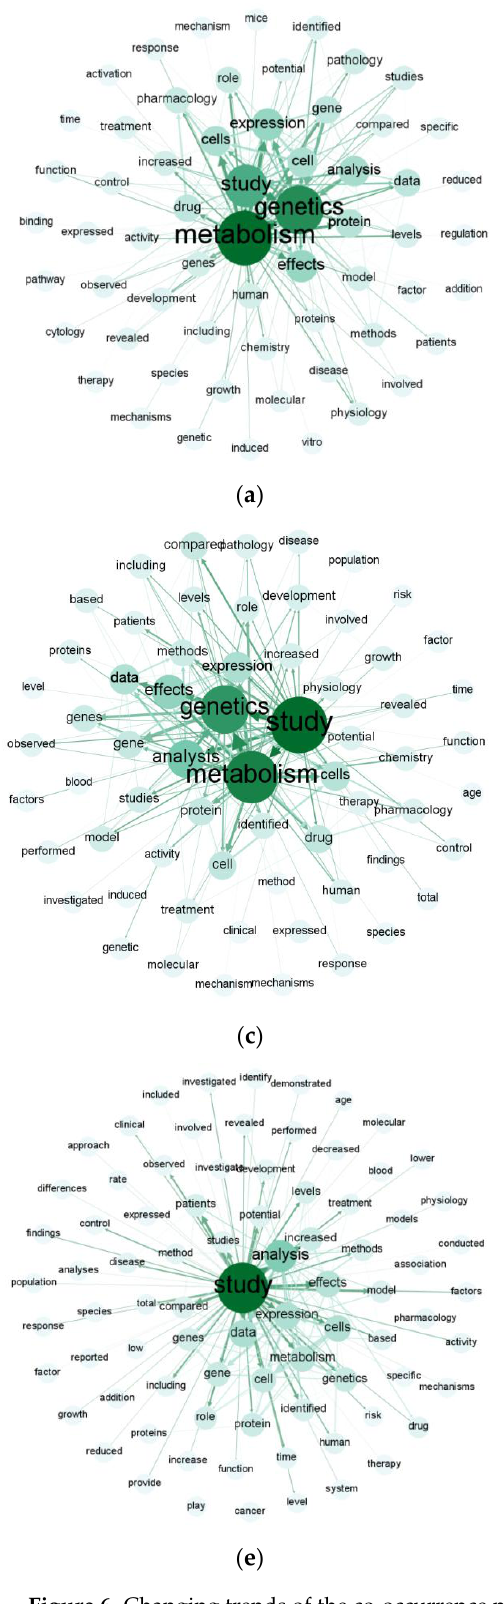
Figure 6. Changing trends of the co-occurrence network of high-frequency words in the bioinformatics literature from 2013 to 2018 with K = 500, E = 200. Figure 6 contained six graphs, which were listed by year: ( a ) 2013, ( b ) 2014, ( c ) 2015, ( d ) 2016, ( e ) 2017, and ( f ) 2018.